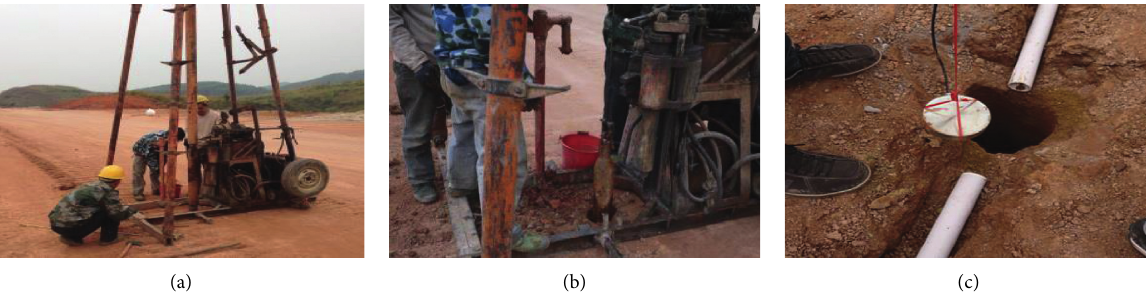
Figure 3: Drilling holes for embedding sensors onsite: (a) equipment being in place, (b) impact hole, and (c) placement sensor.